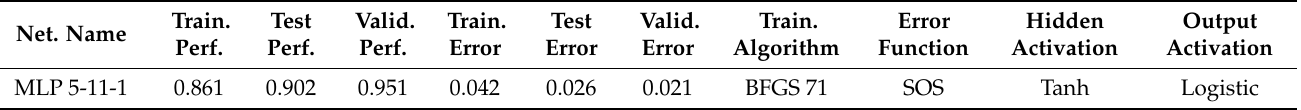
Table 5. Summary of ANN.